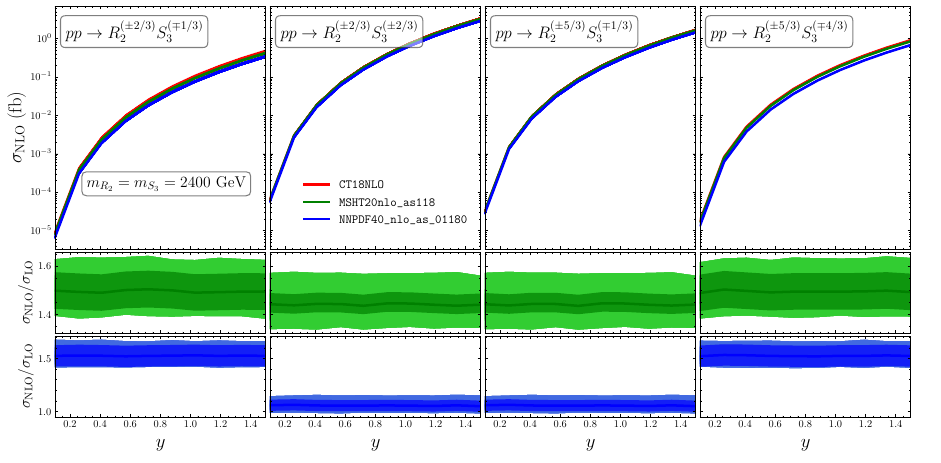
Figure 11 . Same as in figure 4 but for m R